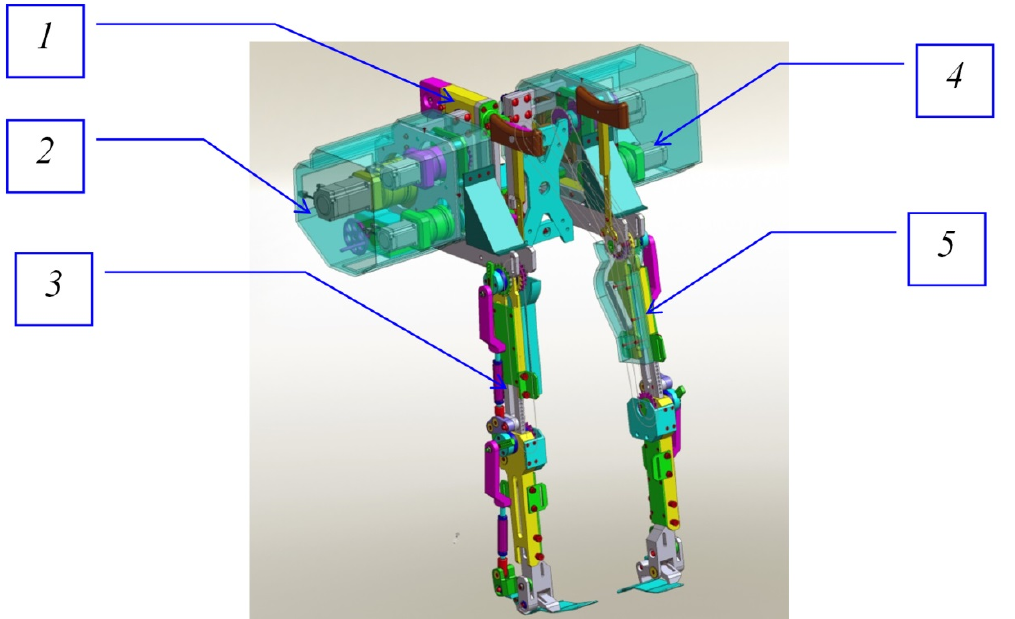
Figure 18. 3D model of the NeuRob exoskeleton with actuation unit.